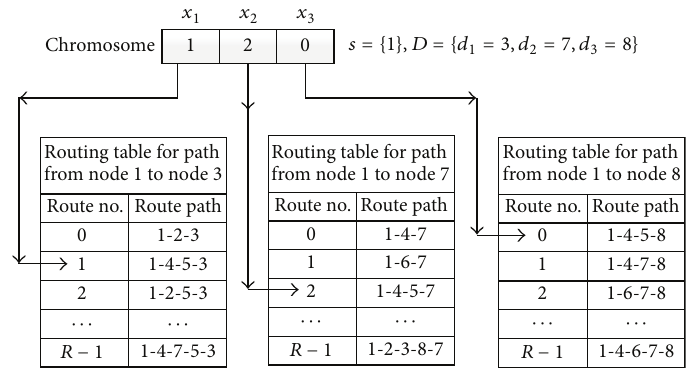
Figure 3: Representation of chromosome, genes, and routing